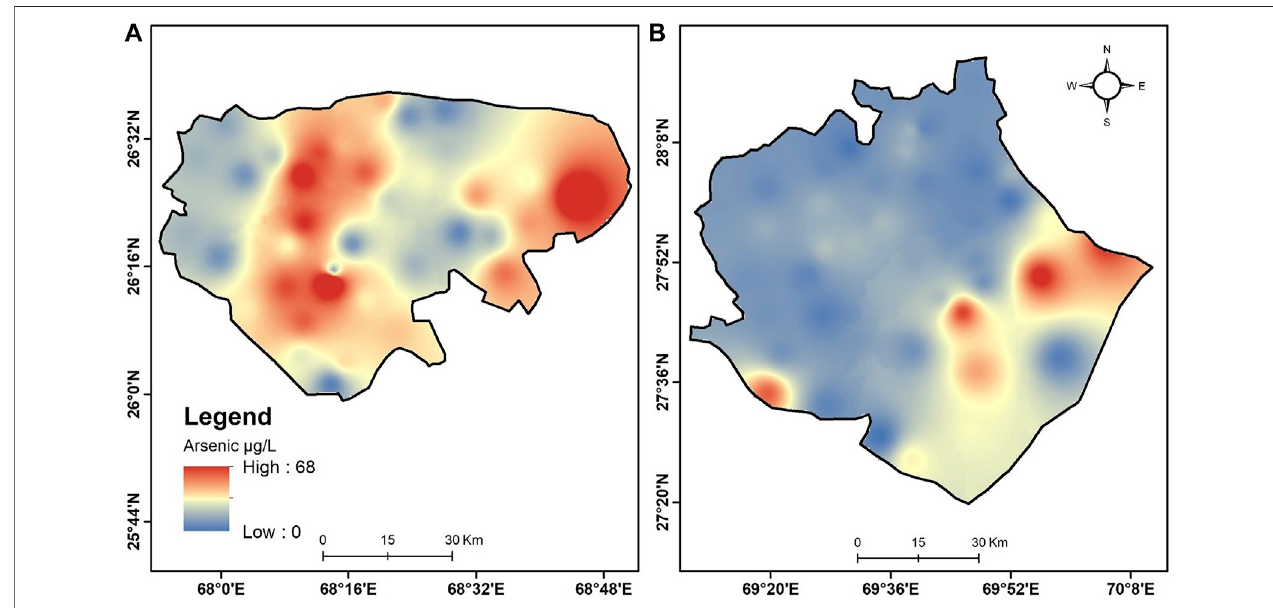
FIGURE 6 | Suitability assessment of WQI in the study area of the (A) Nawab Shah, and (B) Ghotki.